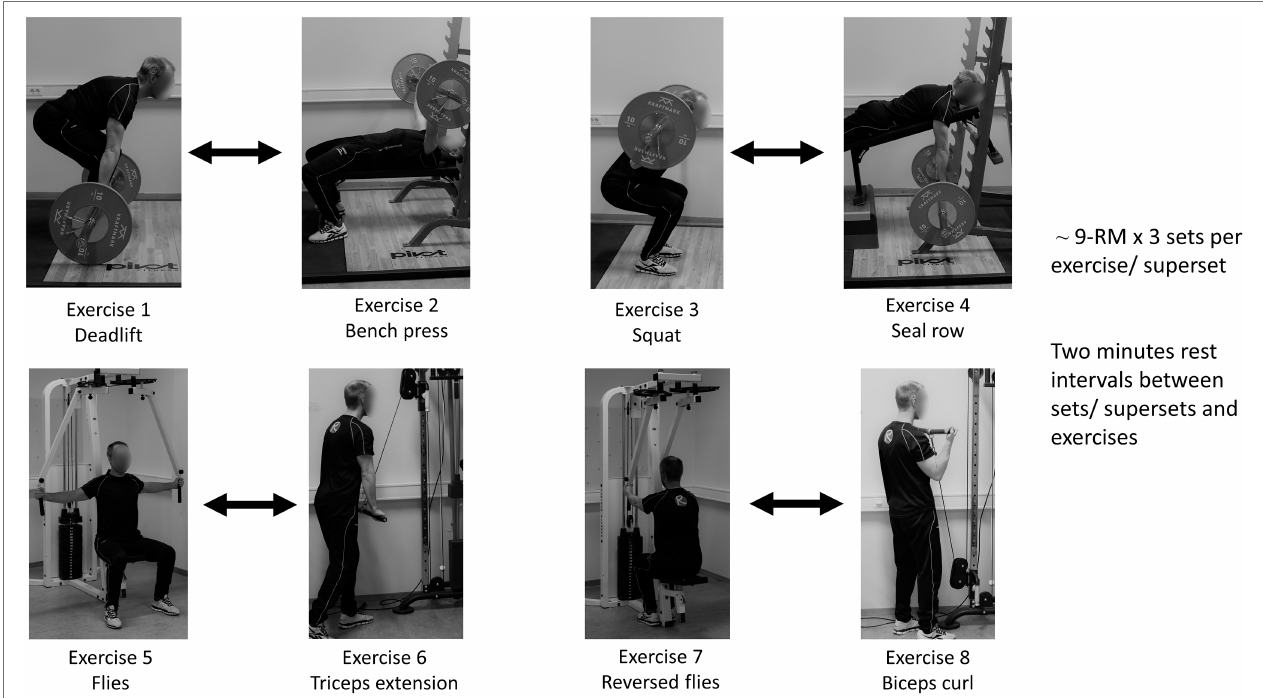
FIGURE 1 | An overview of the traditional and the superset session. Bidirectional arrows indicate exercises performed in the same superset.